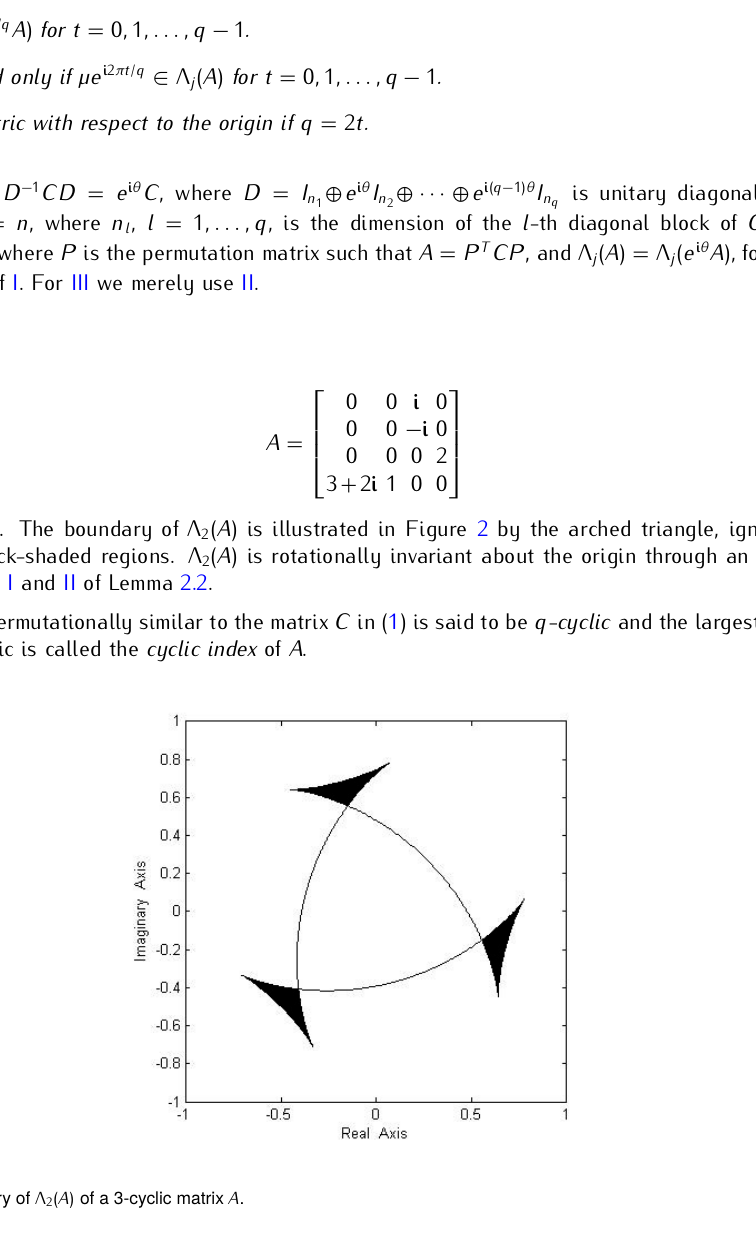
Λ 2 ( A ) of a 3-cyclic matrix A